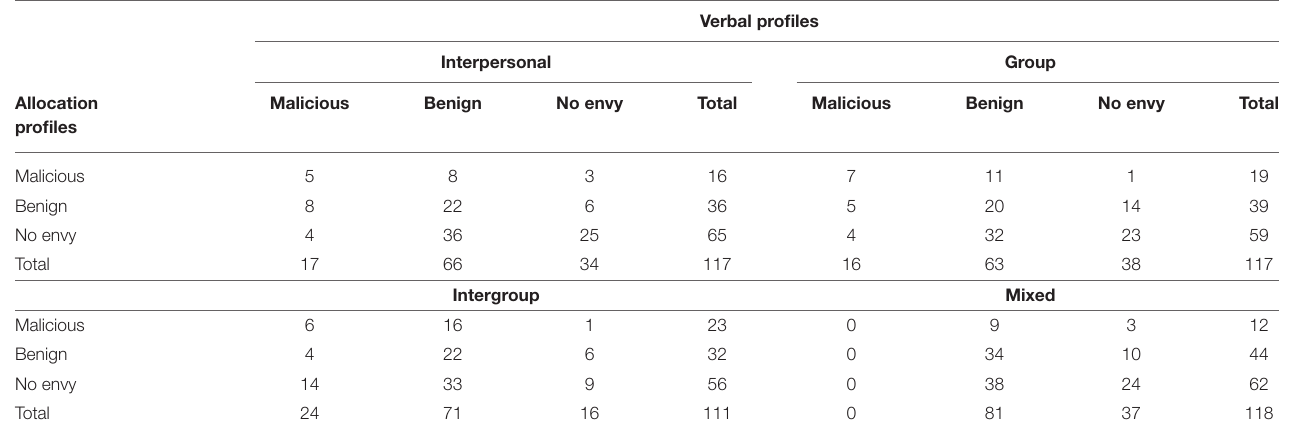
TABLE 2 | Frequencies of participants in verbal and behavioral